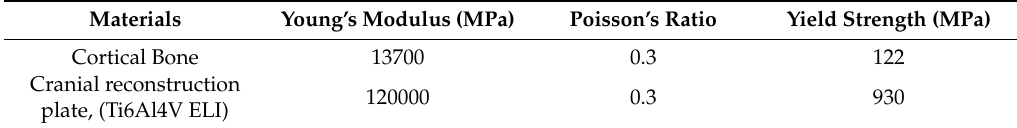
Table 1. Properties of materials utilized in FEA model [18,35].